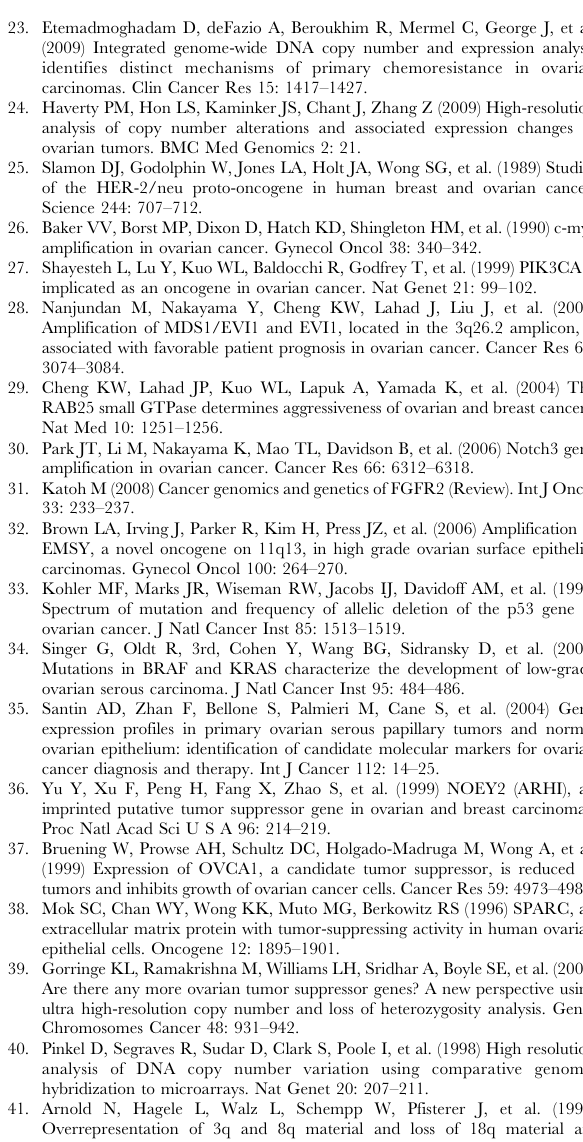
Table S2 List of BACs used for clustering GOG data. (DOC) Table S3 Amplifications and deletion peaks identified by